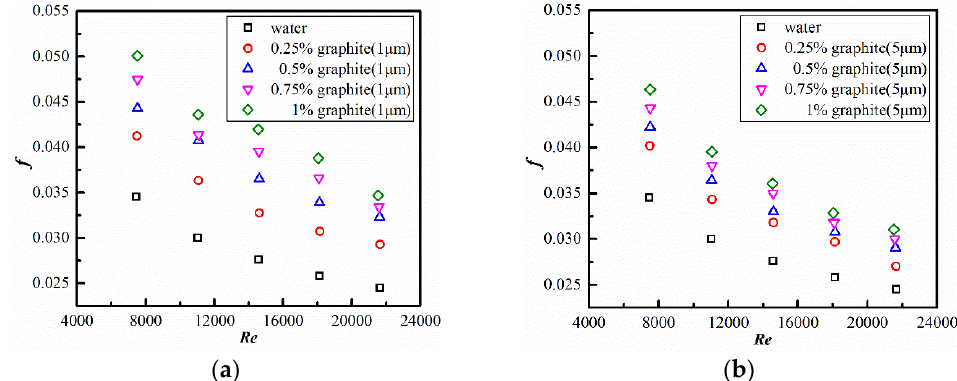
Figure 8. Relation diagram of f with Re of microparticle size: ( a ) a graphite particle size of 1 μ m ; ( b ) a graphite particle size of 5 μ m .